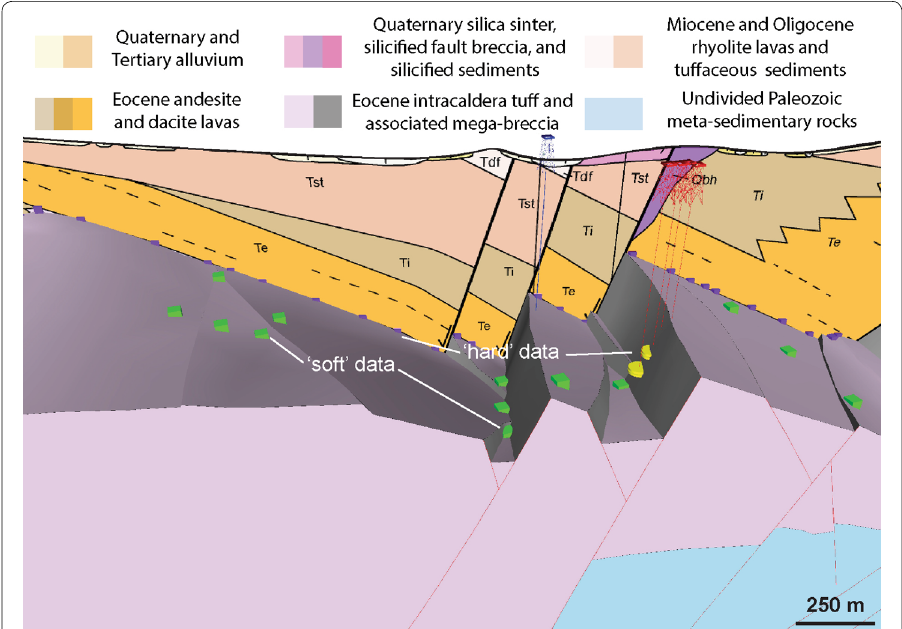
Fig. 6 3D lithologic mapping example from Tuscarora. Data from geologic cross sections (purple cubes) and downhole lithologic interpretation (yellow discs) are ‘hard’ data providing the primary controls on the geometry of the stratigraphic surfaces. ‘Soft’ data (green cubes) constrain the stratigraphic surfaces distal to hard data, such that stratigraphic thickness and the amount of stratigraphic offset across faults are retained. Red wells are production wells; blue wells are injection